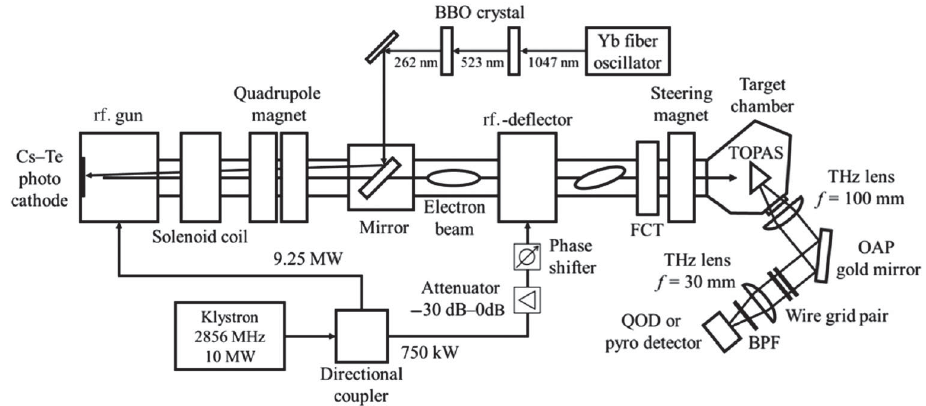
FIG. 3. Experimental